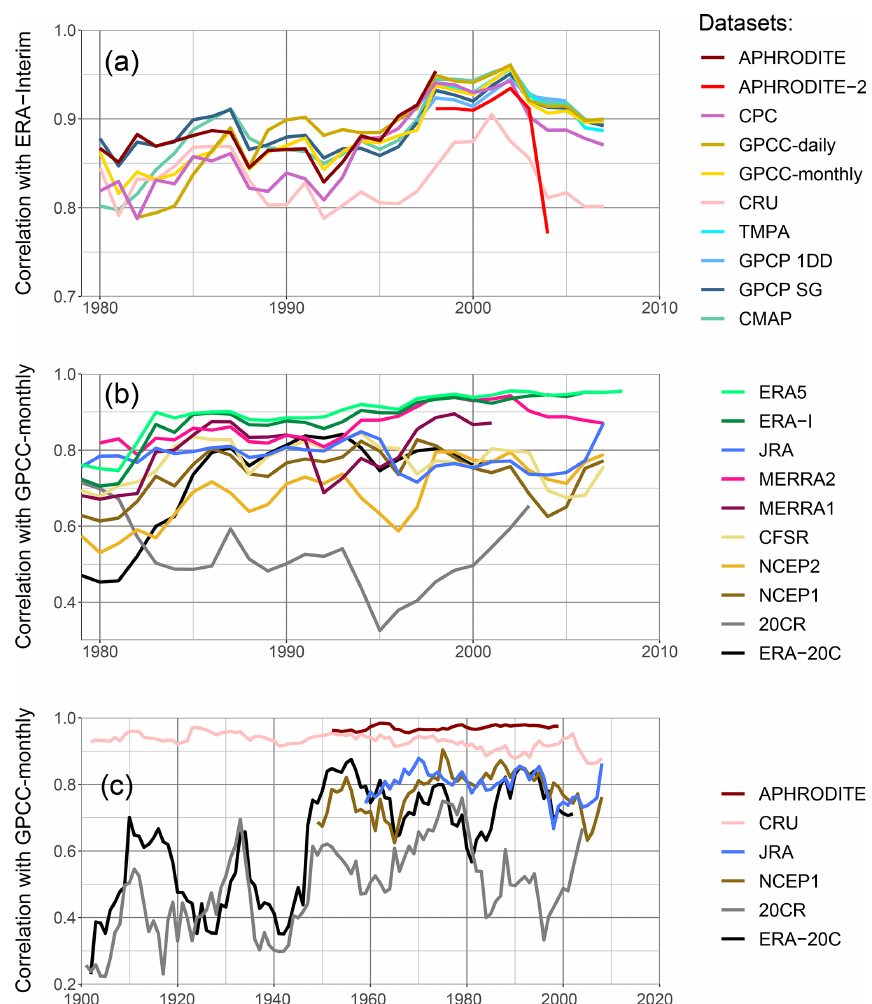
Figure 9. Same as Fig. 8 but for the lower